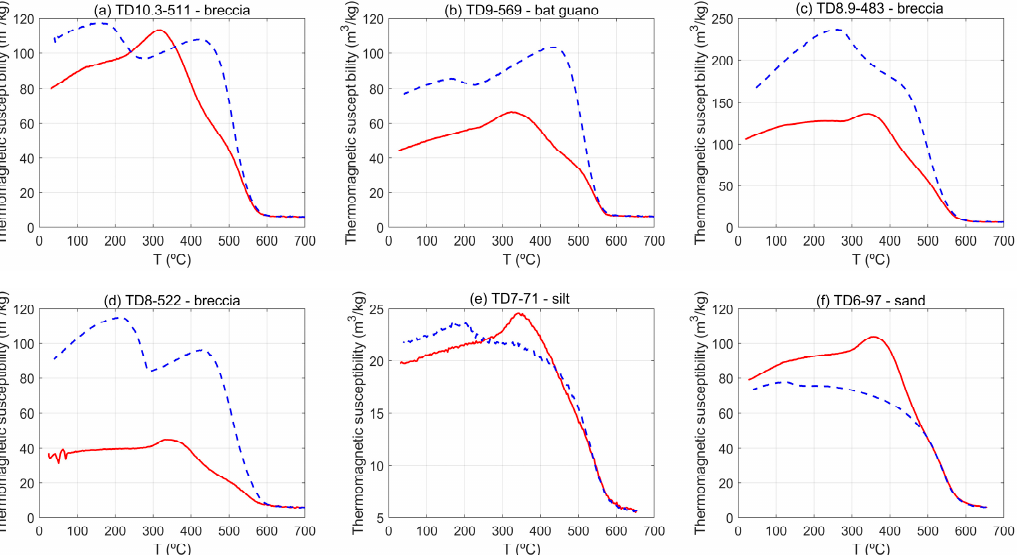
Figure 2. Thermomagnetic curves of the representative samples of each unit in crescent depth. The red line indicates the heating curve, and the dashed blue indicates the cooling.